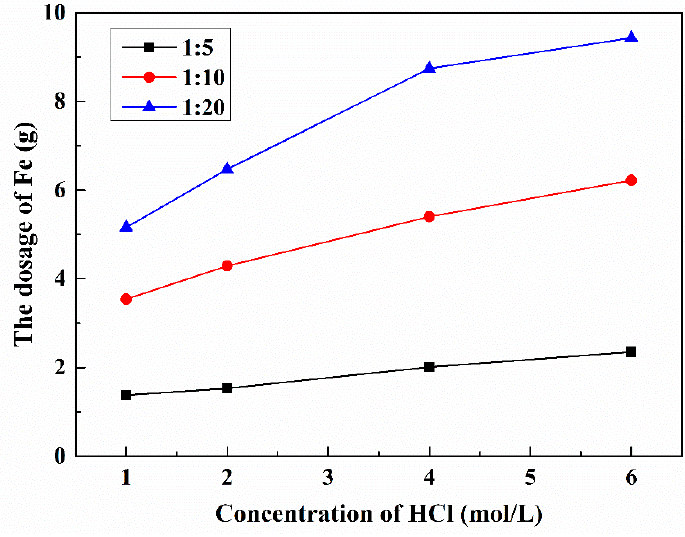
Figure 12. Effect of HCl concentration and S/L ratio on the consumption of Fe during Pt recovery at 90 °C.